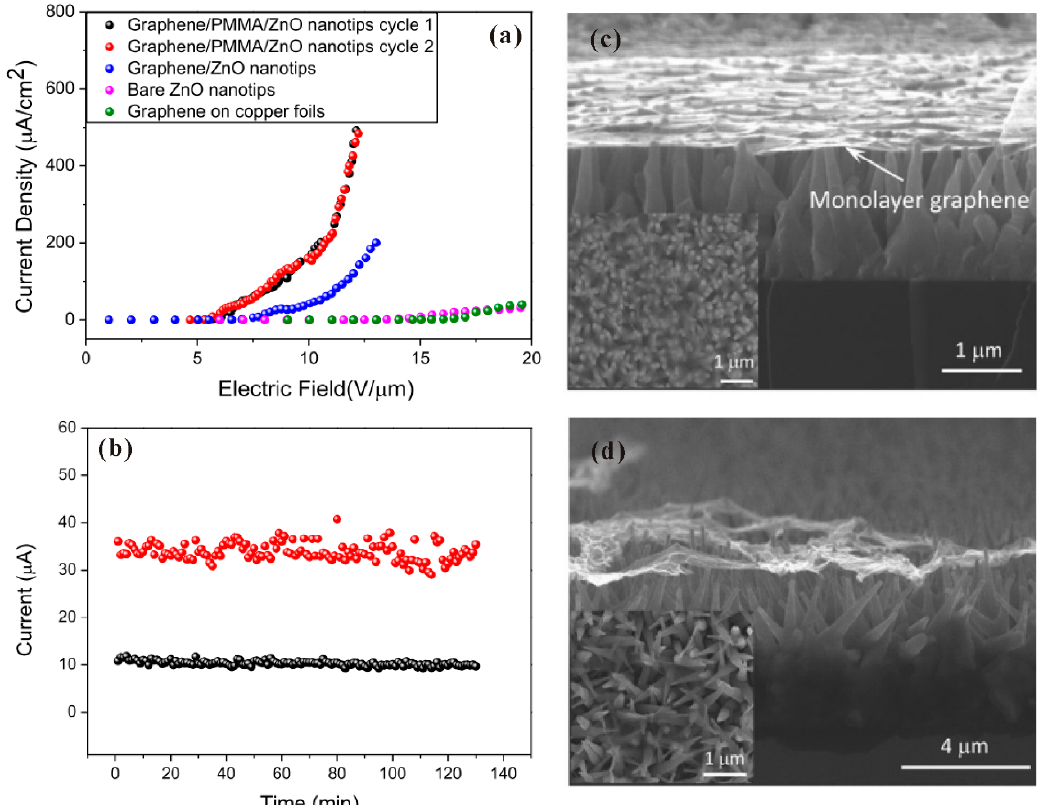
Figure 24. Field emission J-E curves ( a ) and stability ( b ) of the graphene/ZnO nanowires. The SEM images of the hybrid field emitter with ( c ) or without ( d ) using PMMA as the supporting layer. Reproduced from [97], with the permission of AIP Publishing, 2012.